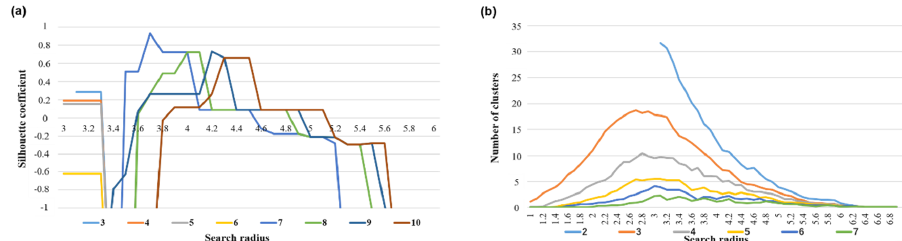
Figure 6. Determining the threshold value: ( a ) the correlation between the Eps value and the contour coefficient with different MinPts values and ( b ) the correlation between the Eps value and the number of clusters with different MinPts values.